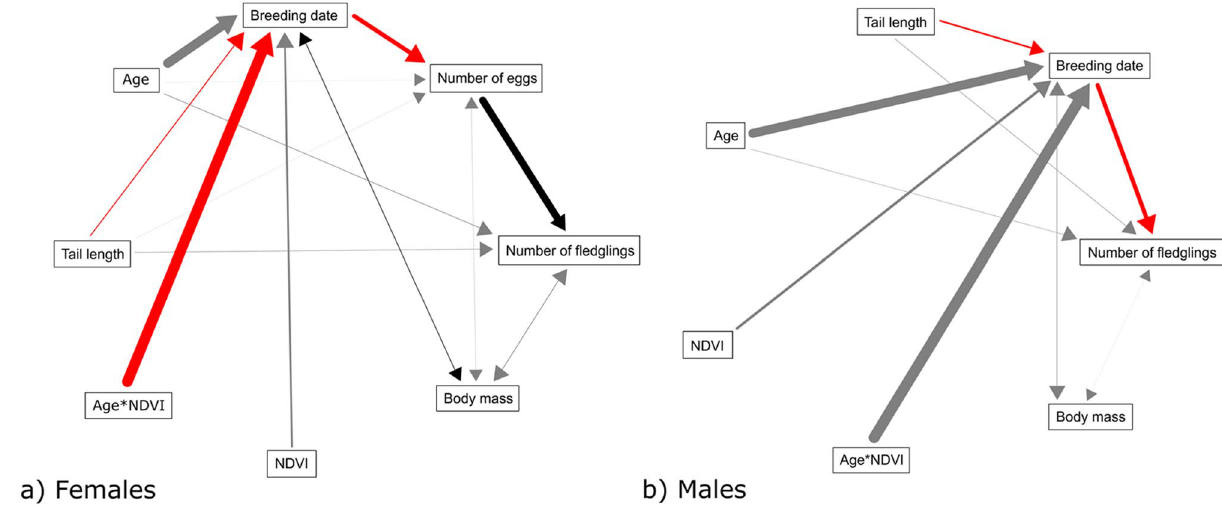
Figure 3. The original version of Figure